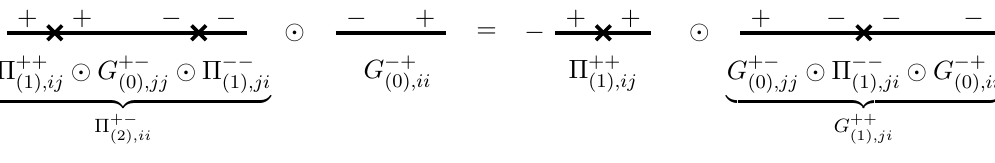
Figure 1 . The equivalence eq. (4.19) between Π − + integration over the internal variable, in terms of Feynman diagrams. A mass insertion is represented by a cross, × , in the